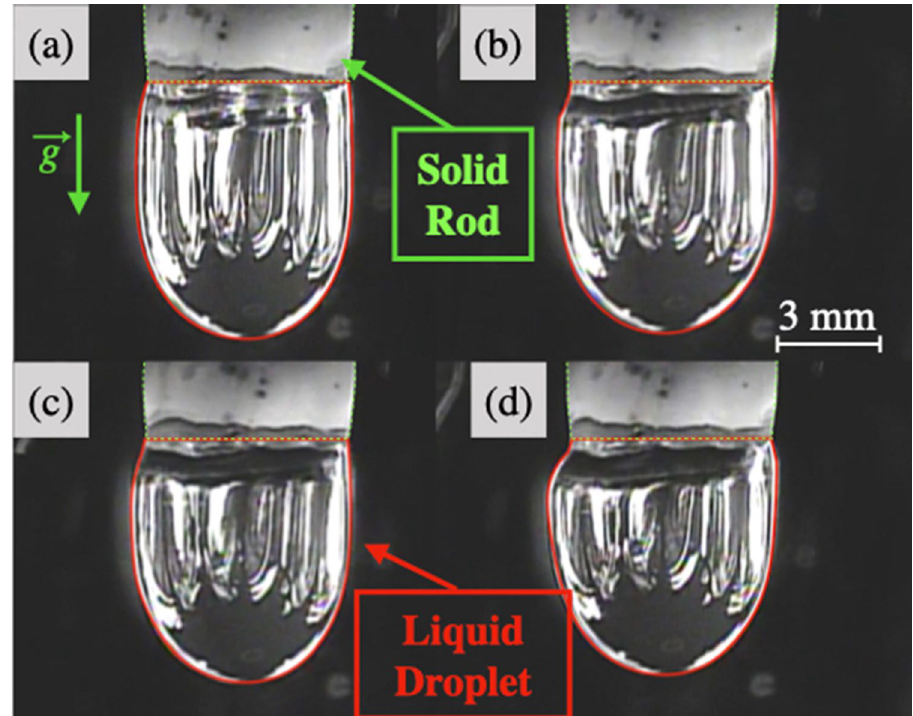
Figure 7. Pictures of La 2 S 3 droplet at ( a ) 2063 K, ( b ) 2051 K, ( c ) 2032 K, ( d ) 2017 K allowing the